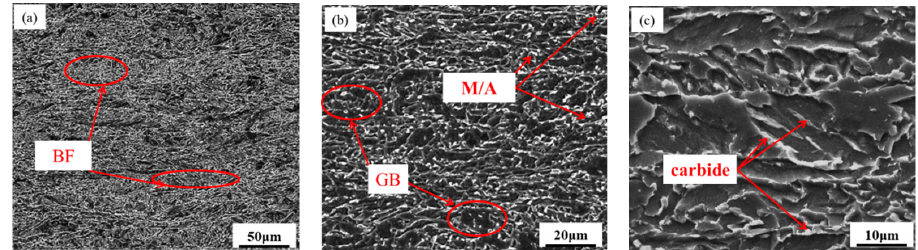
Figure 1. Di ff erent magni fi cations of SEM characterizations for high-grade X100 pipeline steel at 1/4 Figure 1. Different magnifications of SEM characterizations for high-grade X100 pipeline steel at thickness: ( a ) 2000×; ( b ) 5000×; ( c ) 10,000×. 1/4 thickness: ( a ) 2000 × ; ( b ) 5000 × ; ( c ) 10,000 ×